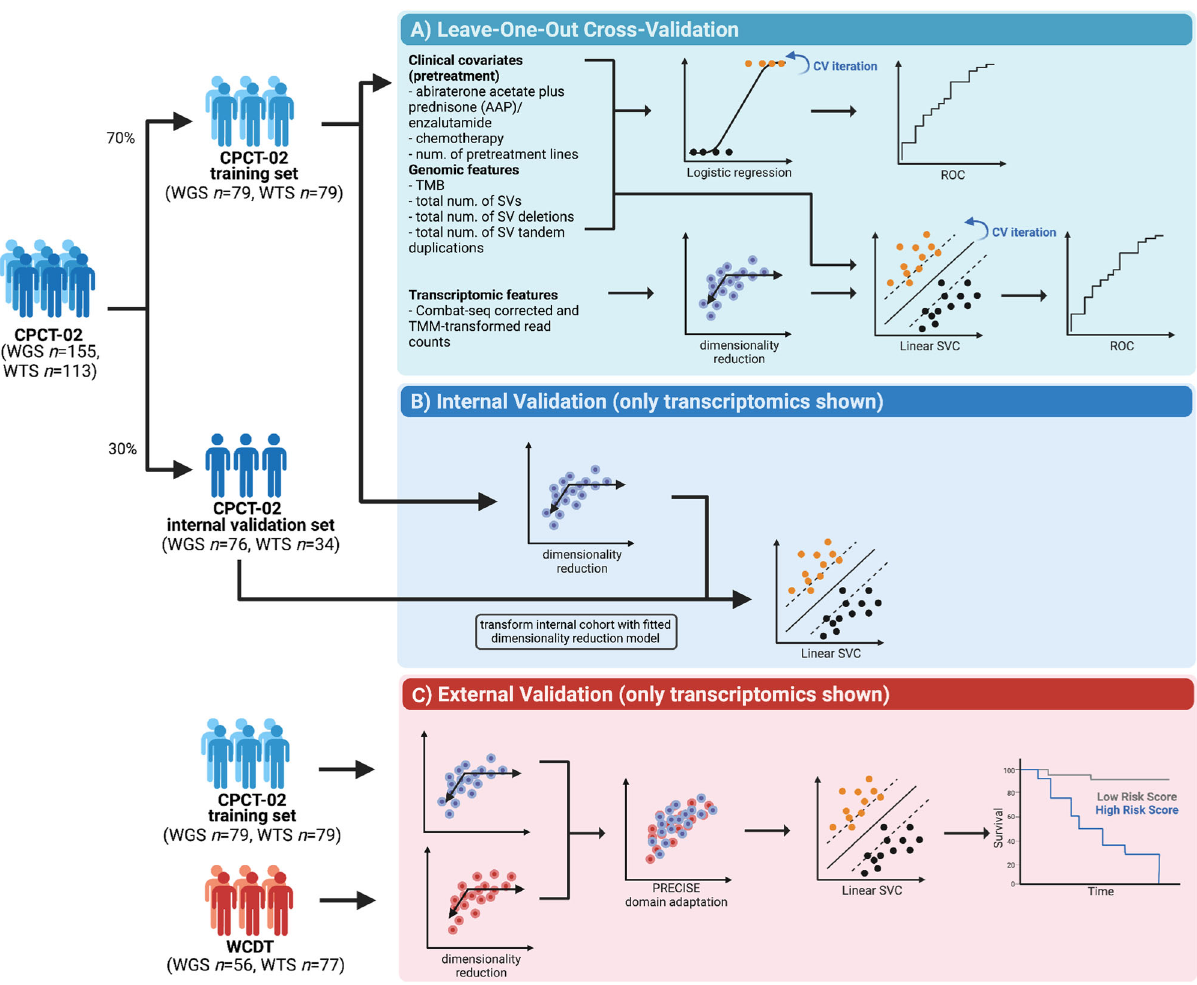
Fig. 2 | Work fl ow of prediction model design and validation. Machine